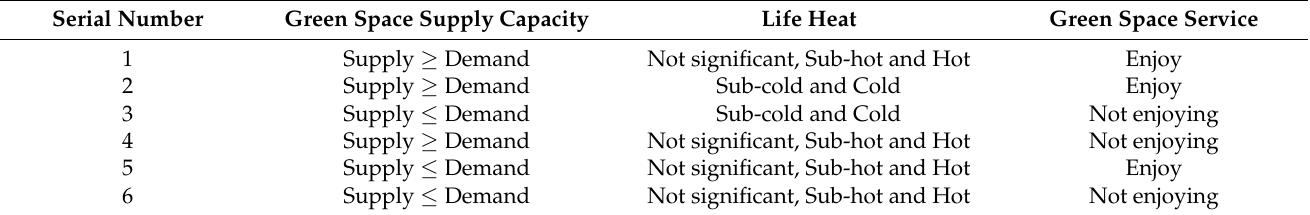
Table 8. Integrated partition